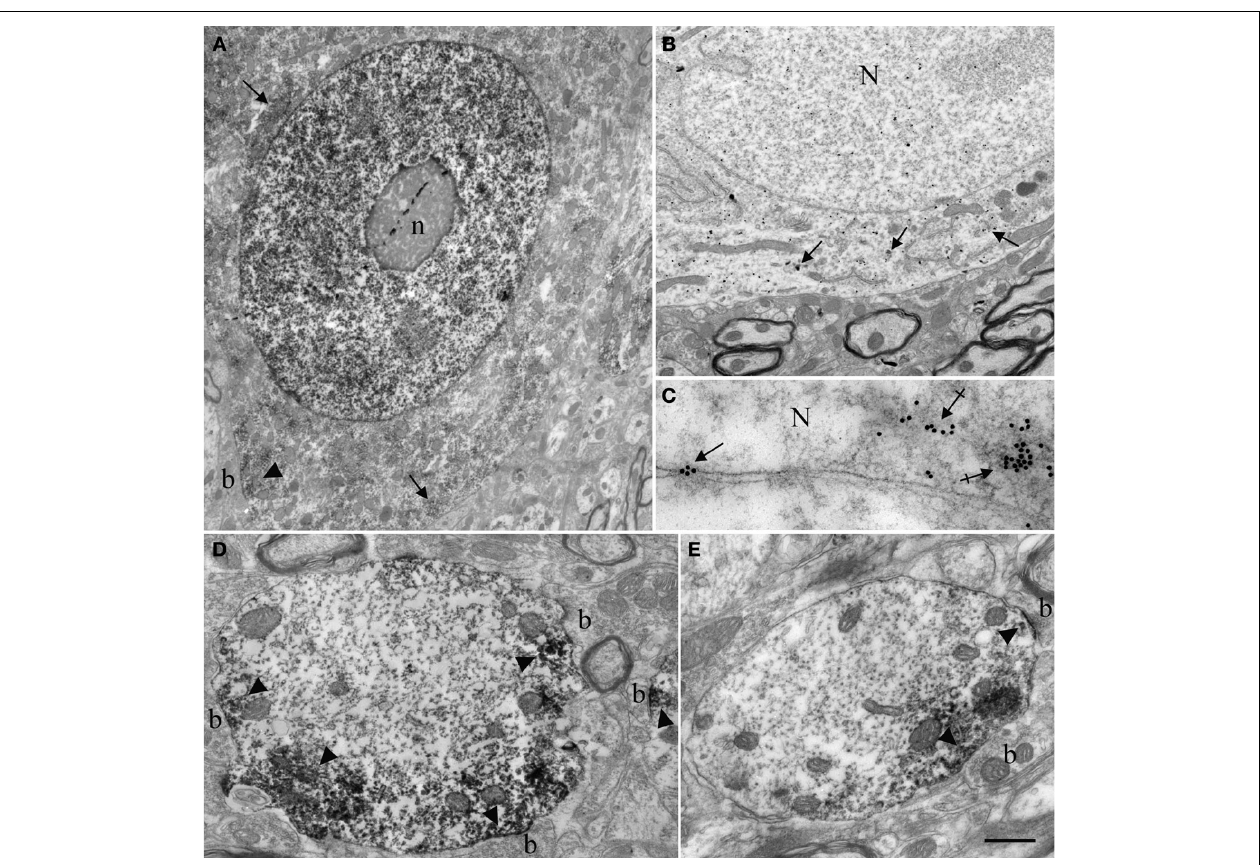
FIGURE 3 | Ultrastructural localization of Nova in the somata and dendrites of ventral horn spinal cord neurons. (A,B) Micrographs of pre-embedding immunocytochemistry experiments. (C) Micrograph of a post-embedding immunocytochemistry experiment. (A) Distribution of Nova visualized with electron dense HRP reaction product (arrows). The nucleus is heavily stained but not the nucleolus (n). Presence of electron dense HRP reaction product (arrowhead) in front of a synaptic contact (b). (B) Gold particles associated with Nova are found within the nucleus (N), as well as within the somatic cytoplasm